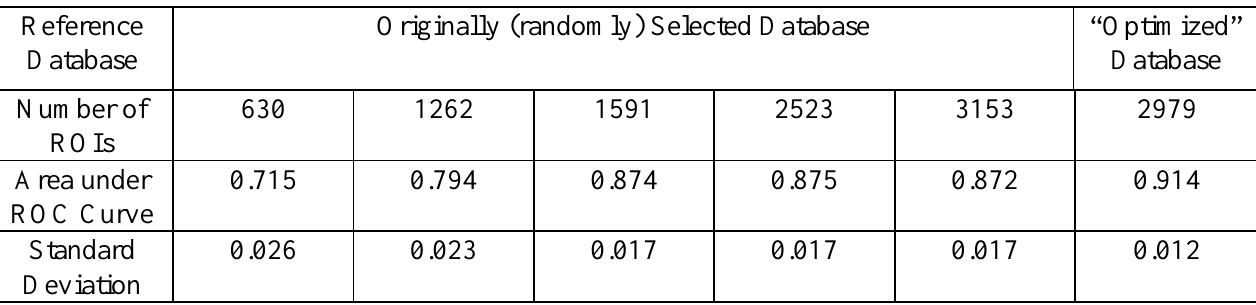
Table 1: The change of CAD performance as the increase of reference database size and eliminating a fraction of “poorly effective” reference ROIs (the “optimized”